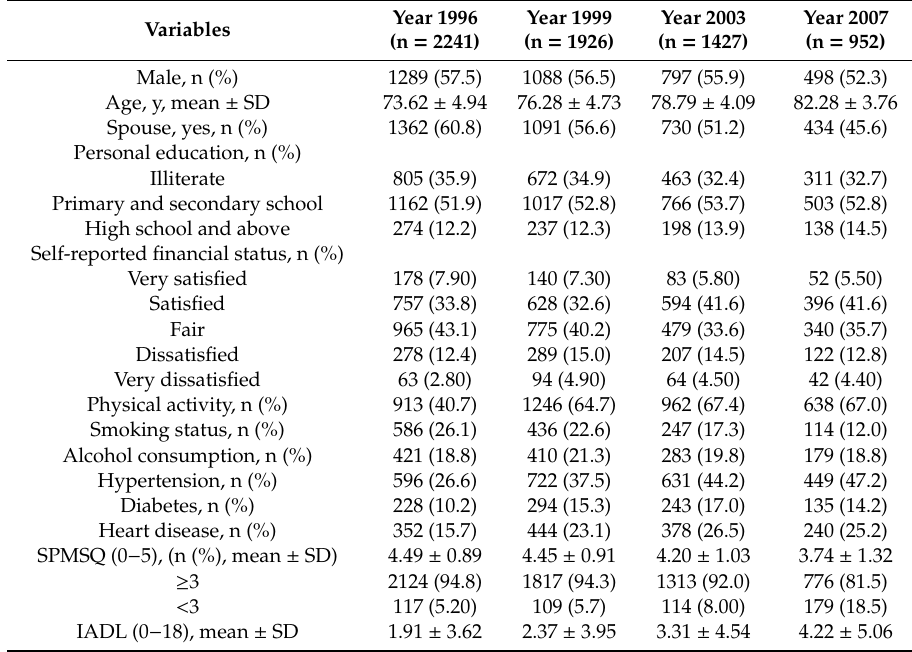
Table 1. Characteristics of TLSA study participants by survey